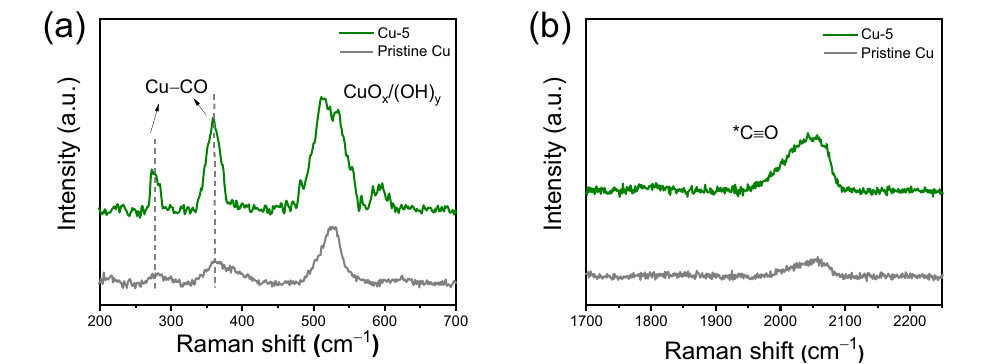
Fig. 5 | Operando Raman spectroscopy. Spectra were collected for pristine Cu (gray) and Cu-5 (green) during CO 2 reduction at two regions, i.e., a low wave- numberrangeat200 – 700cm − 1 and b highwavenumberrangeat1700 – 2250cm − 1